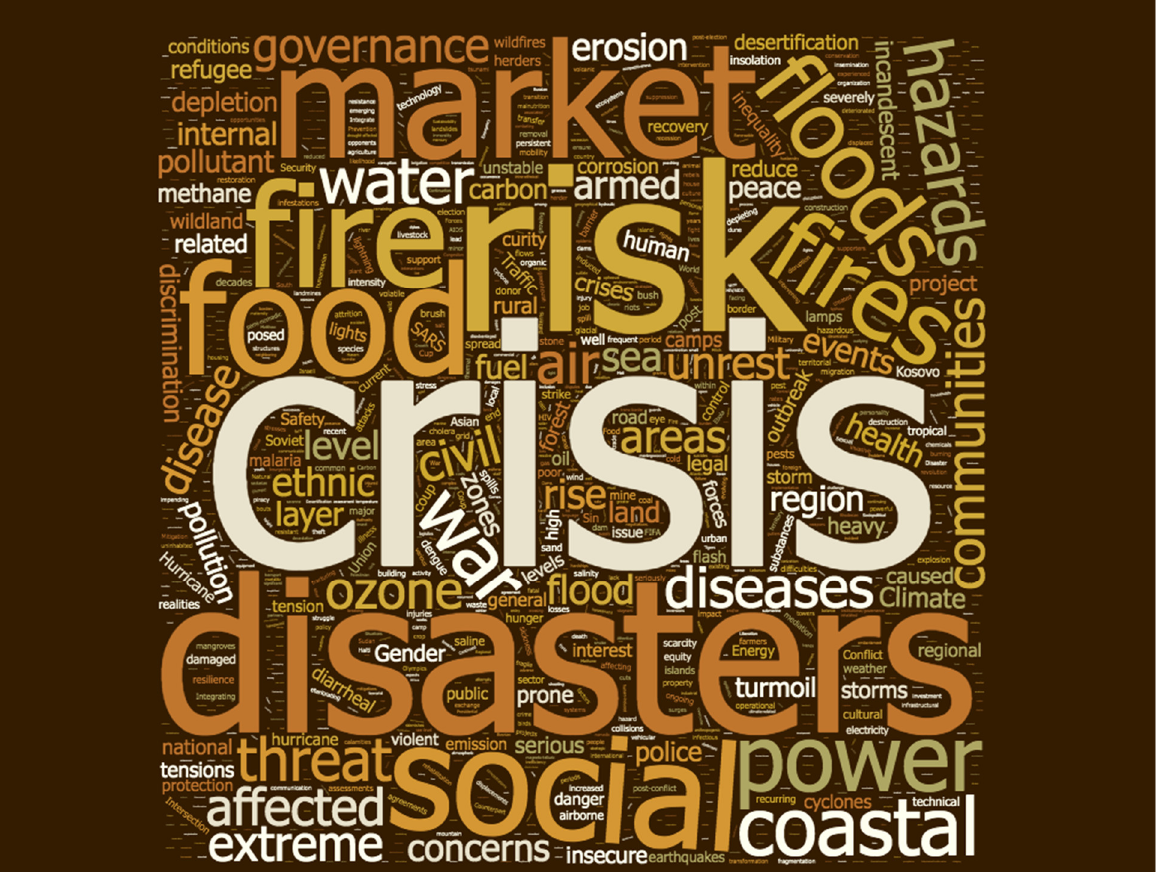
Figure 4. Wordcloud graphic produced from text entities associated with conflict in GEF climate change project terminal evaluations (wordcloud.com accessed 15 April